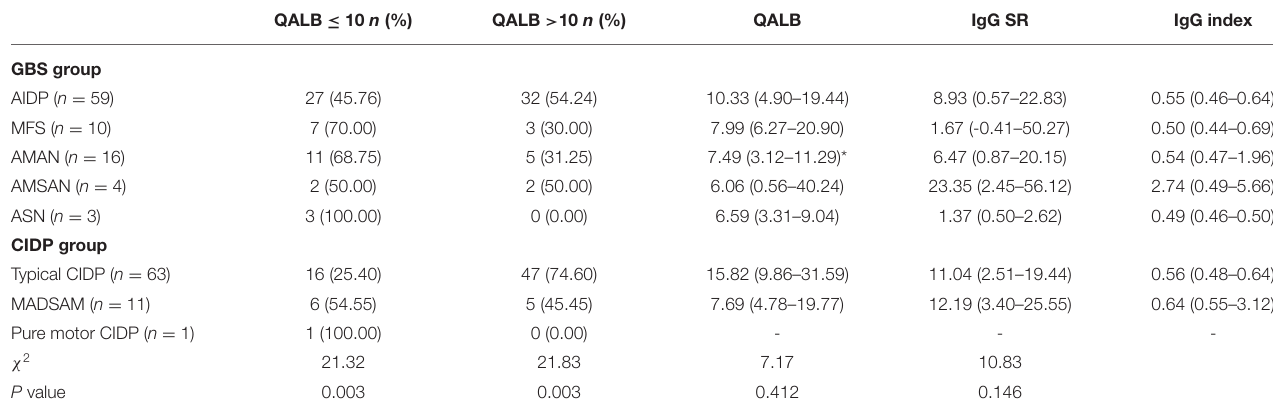
TABLE 4 | Correlation analysis between QALB and GBS, CIDP subtypes M (P25–P75)